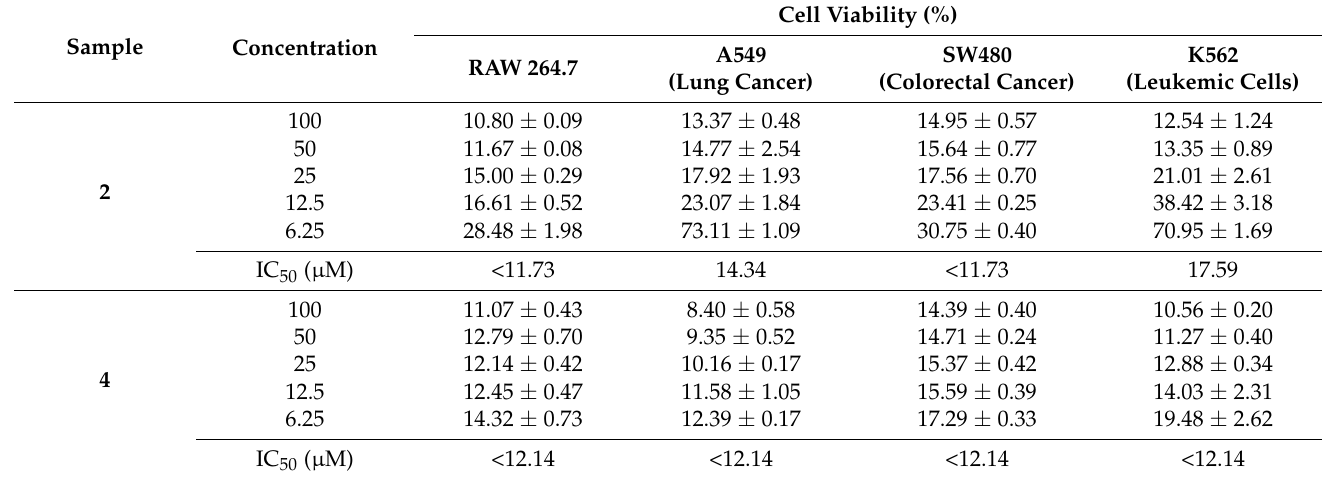
Table 3. Cytotoxicities of Cochlioquinone ( 2 ) and Anhydrocochlioquinone A ( 4